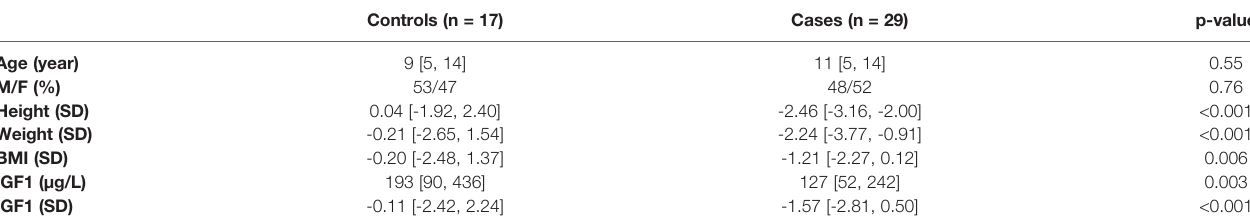
TABLE 2 | General characteristics of age-matched